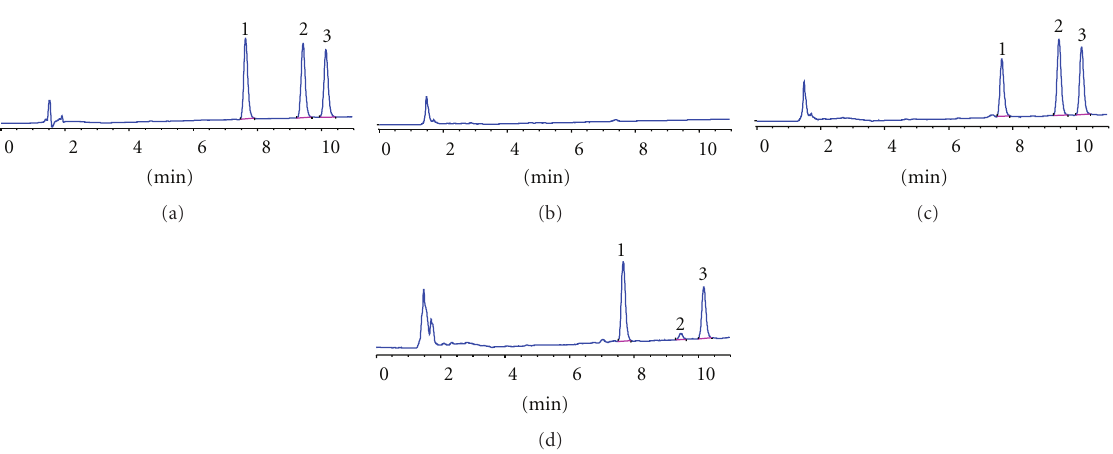
Figure 1: HPLC chromatograms of cortisone and cortisol. (a) Pure standard substance, (b) blank serum, (c) serum spiked with cortisone, cortisol, and internal standard and (d) sample; 1: internal standard, 2: cortisol and 3: cortisone.